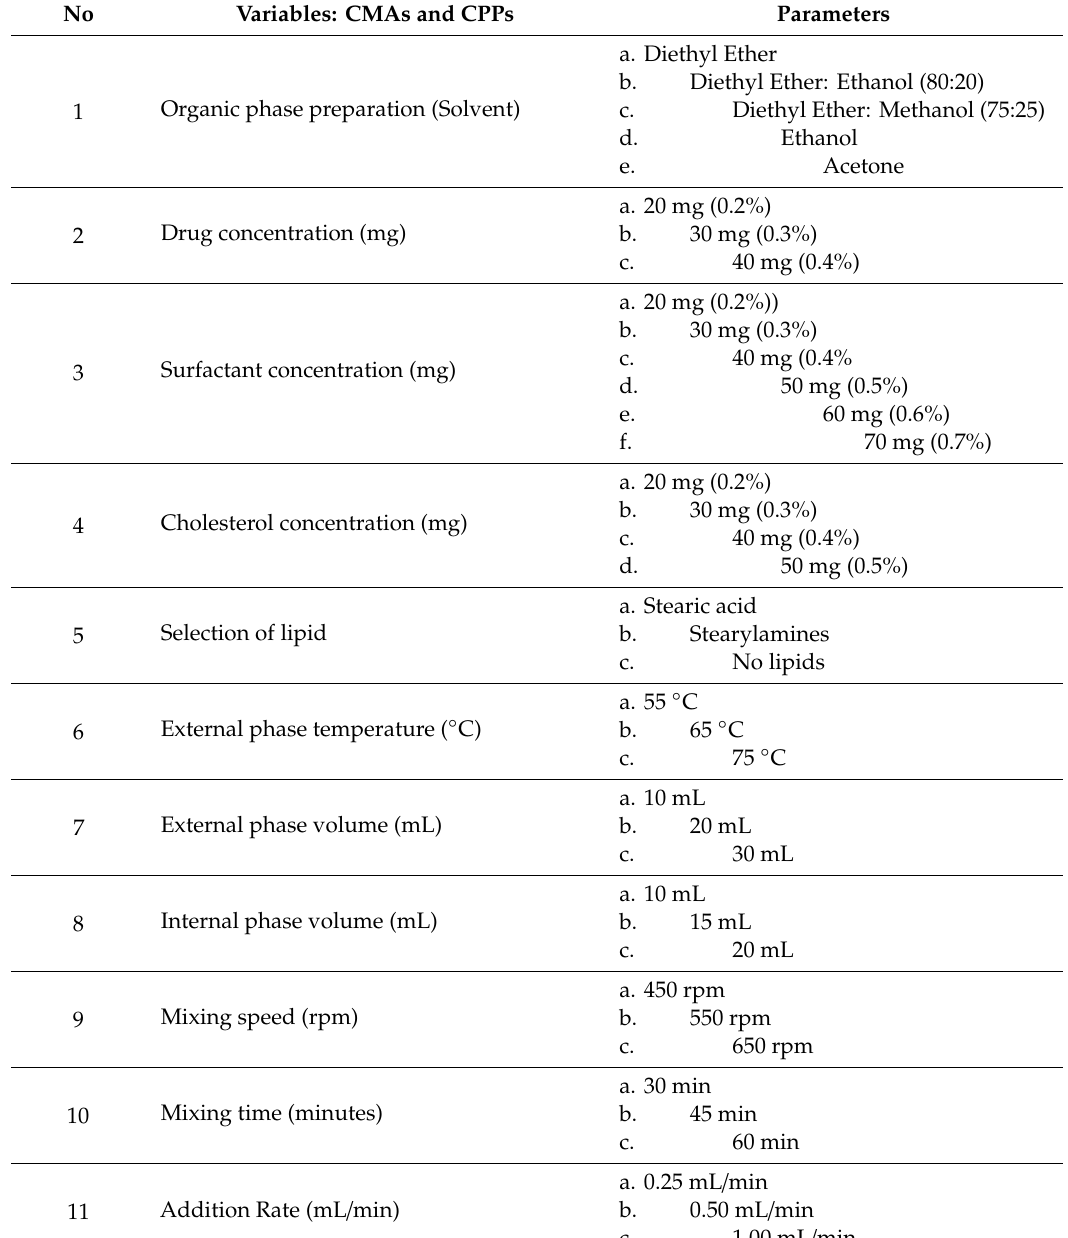
Table 1. Critical material attributes (CMAs) and critical process parameters (CPPs) for the formulation